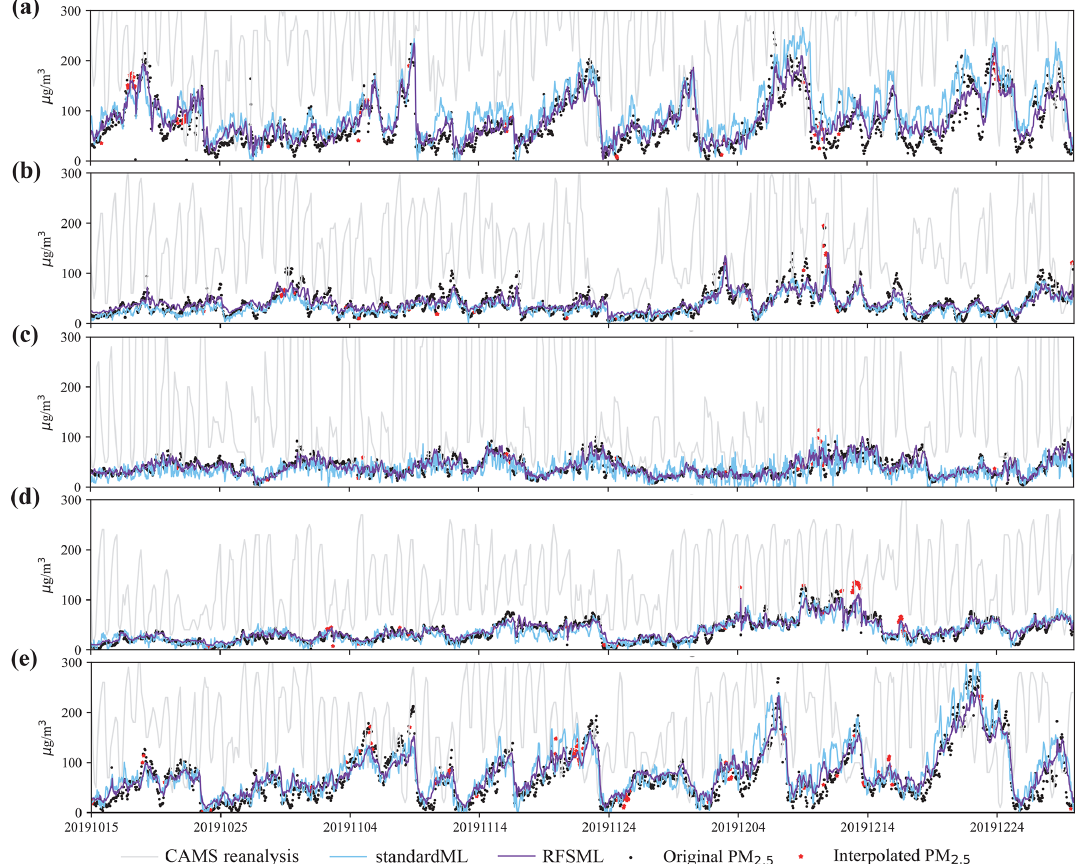
Figure 6. Time series of test time in five megacity cluster regions. The black dots and red pentacles represent original and interpolated PM 2 . 5 respectively. The solid lines in light gray, light blue, and dark violet represent prediction of CAMS reanalysis, the standard machine learning system and RFSML respectively. Panels (a) – (e) represent a random site in NCP, YRD, PRD, SCB, and FWP respectively. Note that those are predictions 12h in advance, which are in parallel with CAMS reanalysis’s predicting horizon, and the machine learning model used here is